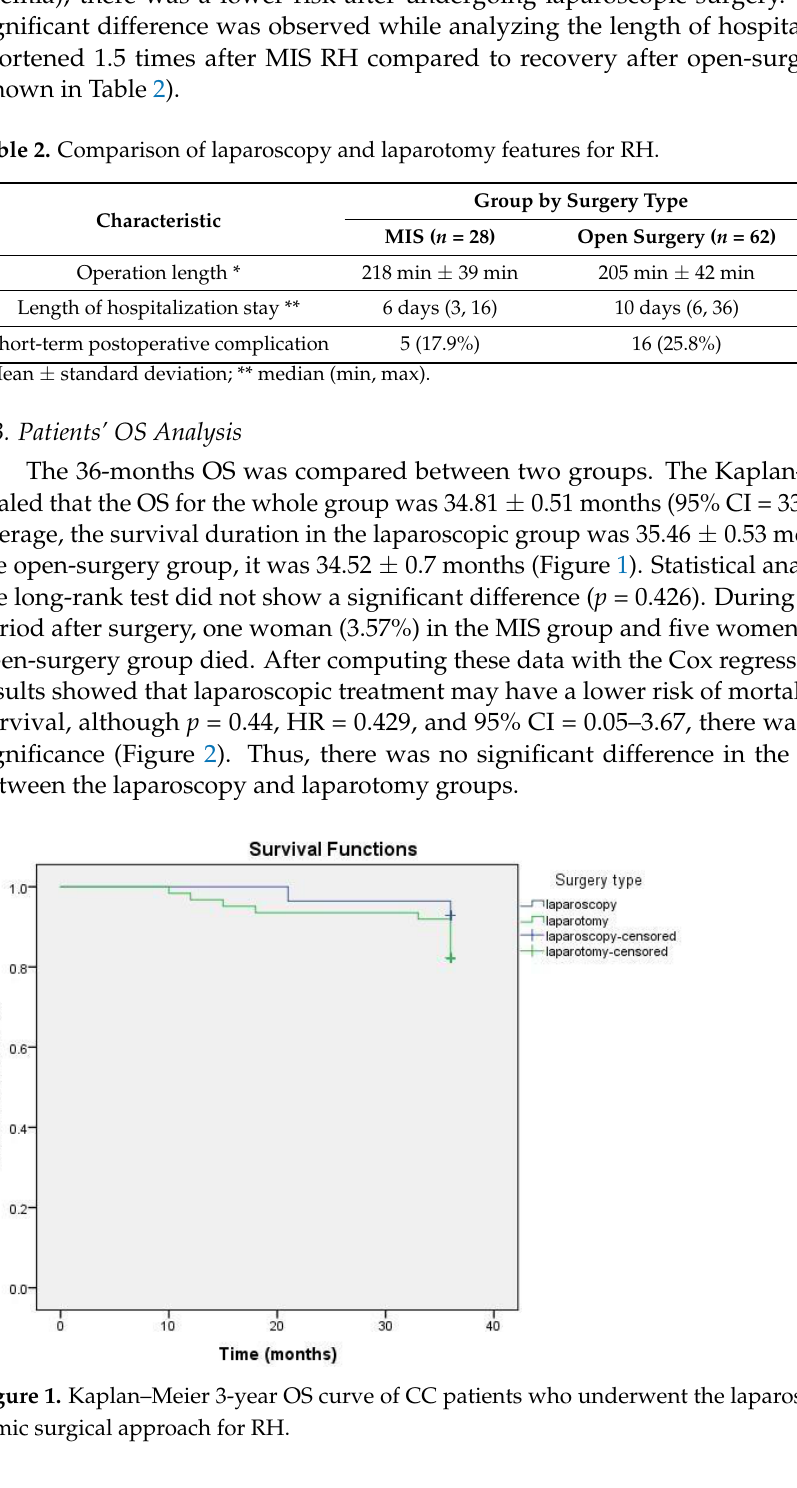
Figure 2. Cox (proportional hazards) regression curves for 3-year OS between laparoscopic and lap- arotomic surgical approach for RH. 4. Discussion The results of the LACC trial, announced at the Society of Gynecologic Oncology (SGO) 2018 annual meeting, have attracted significant attention [18]. Due to the enormous difference in survival in favor of open surgery, this trial was stopped prematurely. In comparison, MIS has been shown to have better surgical outcomes with equivalent sur- vival rates in patients affected by endometrial, colorectal, and gastric cancers in previously randomized trials. In the retrospective analysis using the Surveillance, Epidemiology, and End Results (SEER) data of the National Cancer Institute (NCI) in the US, the introduction of MIS cor- related with a decrease in survival rate due to CC, thus further corroborating the results